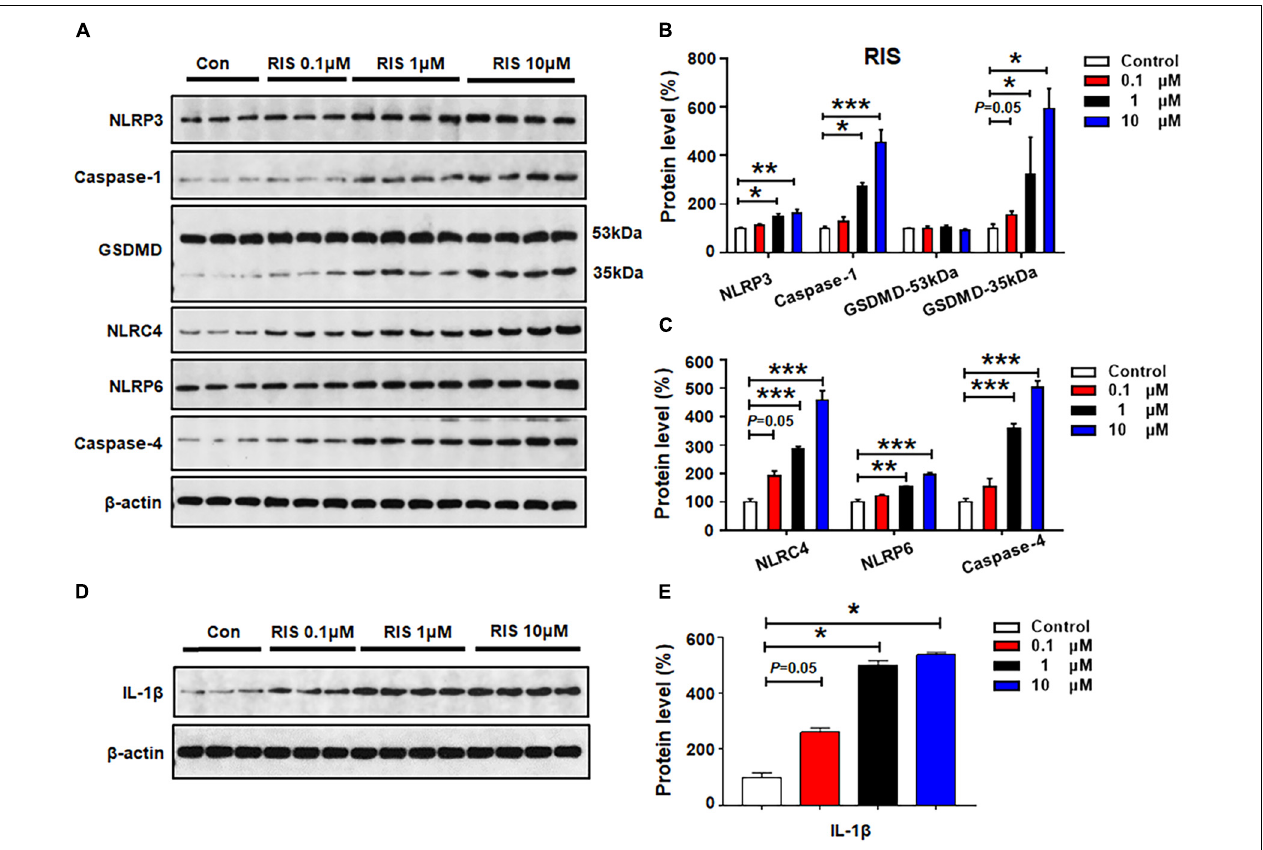
FIGURE 4 | Risperidone treatment activated NLRP3/caspase-1 signaling and increased NLRC4, NLRP6, and IL-1 β protein expression in cultured astrocytes. Cells were treated with 0.1, 1, or 10 µ M risperidone for 24 h. (A–E) Western blot was used to examine the expression of NLRP3, caspase-1 (20 kDa), GSDMD (53 and 35 kDa), NLRC4, NLRP6, and IL-1 β . The data are presented as the mean ± standard error of the mean. * p < 0.05, ** p < 0.01, *** p < 0.001 vs. control (one-way analysis of variance and post hoc Dunnett’s multiple comparison test; n = 3–4 cultures/western blot group). Con, control; RIS,